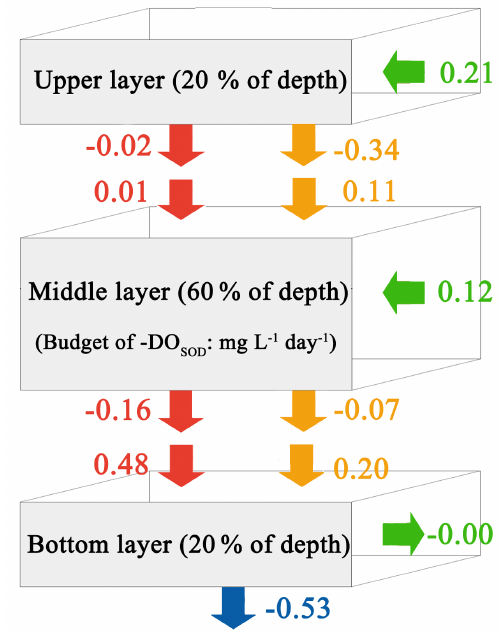
Figure 9. Budget of − DO SOD for the upper layer, middle layer, and bottom layer in the PRE for the Base simulation. Blue arrows repre- sent sediment oxygen demand, red arrows represent the vertical dif- fusion, orange arrows represent vertical advection, and green arrows represent horizontal advection. Positive values mean the source ef- fects, while the negative values mean the sink effects of the sedi- ment oxygen demand on DO concentrations (unit: mgL − 1 day − 1